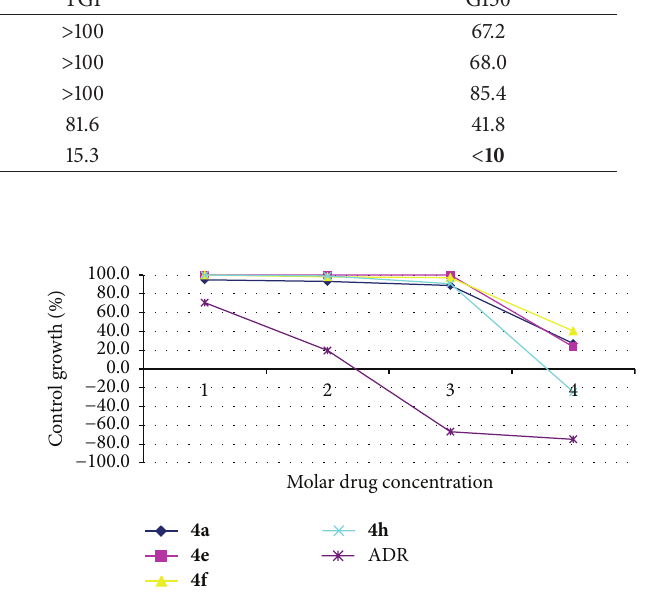
Figure 1: In vitro cytotoxic effects of amino acid Schiff bases against human colon cancer cell line